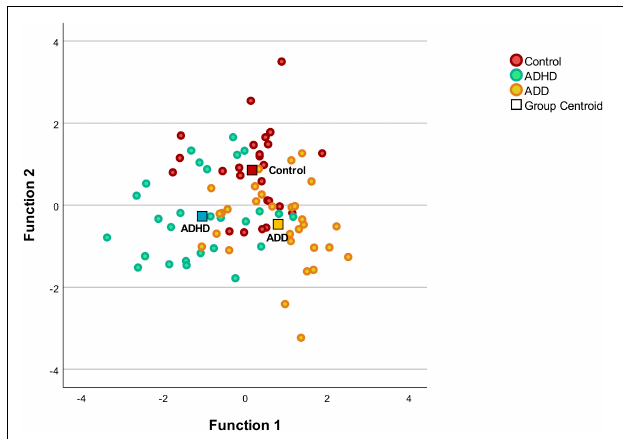
FIGURE 2 | Discriminant plot. Function 1 discriminates the control group and the ADD from the ADHD, while the function 2 discriminates the disorder groups (ADD and ADHD) from the control group. The correlations between the outcomes and the discriminant functions revealed that the loads onto the first function are high for the right P1 latency ( r = 0.58), the right HG ( r = 0.43), the right HG/PT ( r = 0.42), and the right PT ( r = 0.41). The correlations between the outcomes and the second discriminant functions revealed that the loads onto the second function are high for the left HG/PT ( r = 0.65), the left HG ( r = 0.58), and the absolute P1 latency asynchrony ( r =